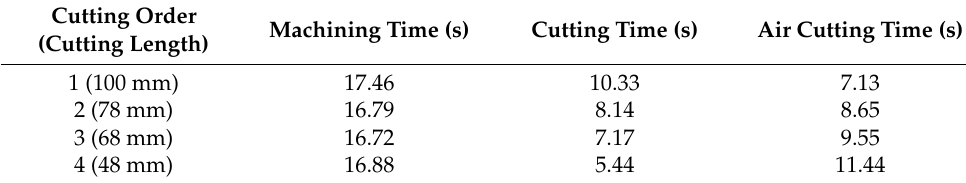
Table 9. Results of experiment 4 with empty